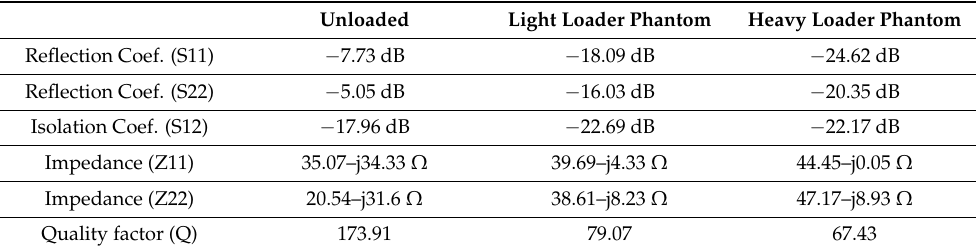
Table 3. Experimental S-parameters and Q-factor measurement for constructed split-type elliptical birdcage in unloaded and loaded conditions. S-parameter was measured at each splitter/combiner port, and Q-factor was measured using two weakly coupled sniffer probes placed at opposite ends of the RF